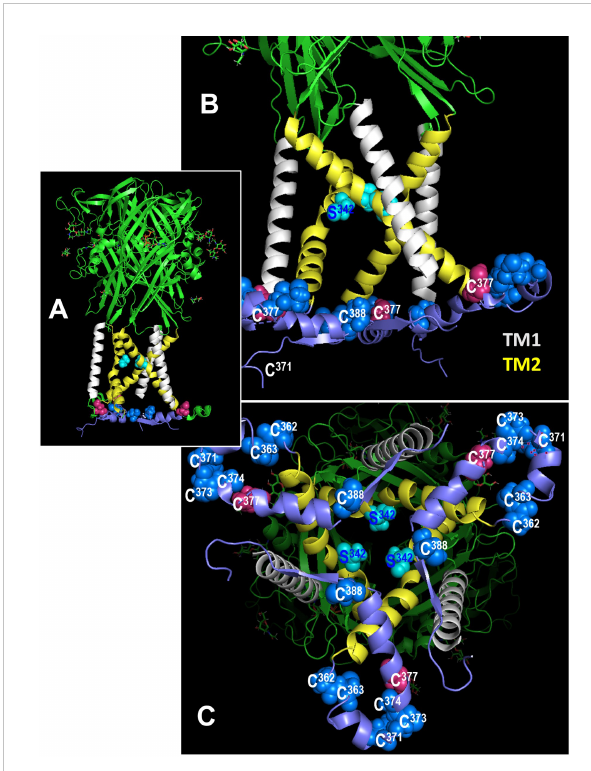
FIGURE 8 Location of cysteines C377 and C388 in the rat P2X7 receptor (rP2X7R) in the open channel conformation. In all fi gures, the C- terminal residues 400-595 to the end of the 595 residues long subunits are hidden for simplicity. (A) Side view of the large extracellular domain harboring the ATP binding sites, the six transmembrane domains (3 x TM1 in white, 3 x TM2, in yellow), and an interfacial helically structured domain lying parallel to the membrane plane. Also shown are the three S342 residues, which constitute the channel gate (46). (B) Enlarged side view of the transmembrane domains, the S342 residues (cyan) and the position of two (of three each) residues C377 and C388 in the interfacial region. The other blue spheres indicate additional cysteines of the cysteine-rich domain. (C) Perpendicular view from the cytoplasmic side on the numerous cysteine residues of the interfacial region and the transmembrane domains above.